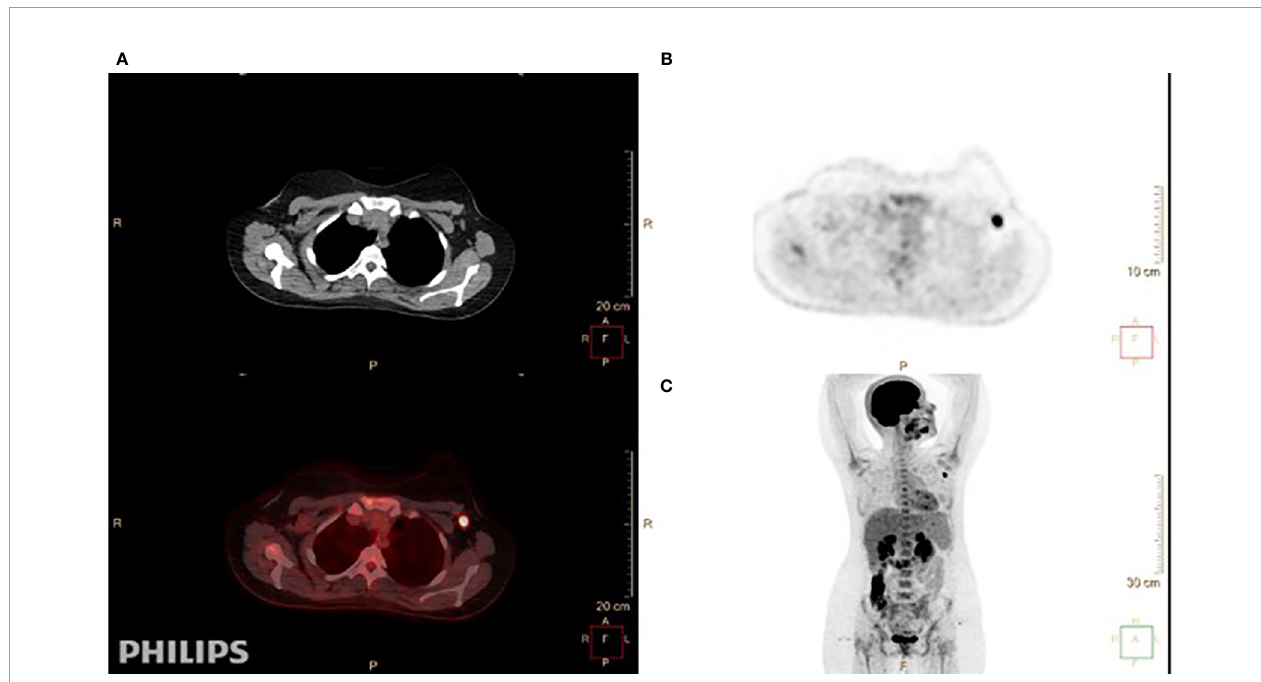
FIGURE 2 | A 24-year-old-female patient with invasive ductal carcinoma in the left breast, grade II, estrogen receptor (ER)-positive, progesterone receptor (PR)- positive, and HER2-negative. She had T1, N1, Mx disease. (A) Axial 18 F-FDG-PET/CT showed fl uorodeoxyglucose (FDG)-avid left axillary lymph nodes. The largest and most avid measures 1 × 1.6 cm with SUV max of 9.8. (B, C) Axial (B) and coronal (C) views demonstrate high FDG uptake for the enlarged node in the left axilla.